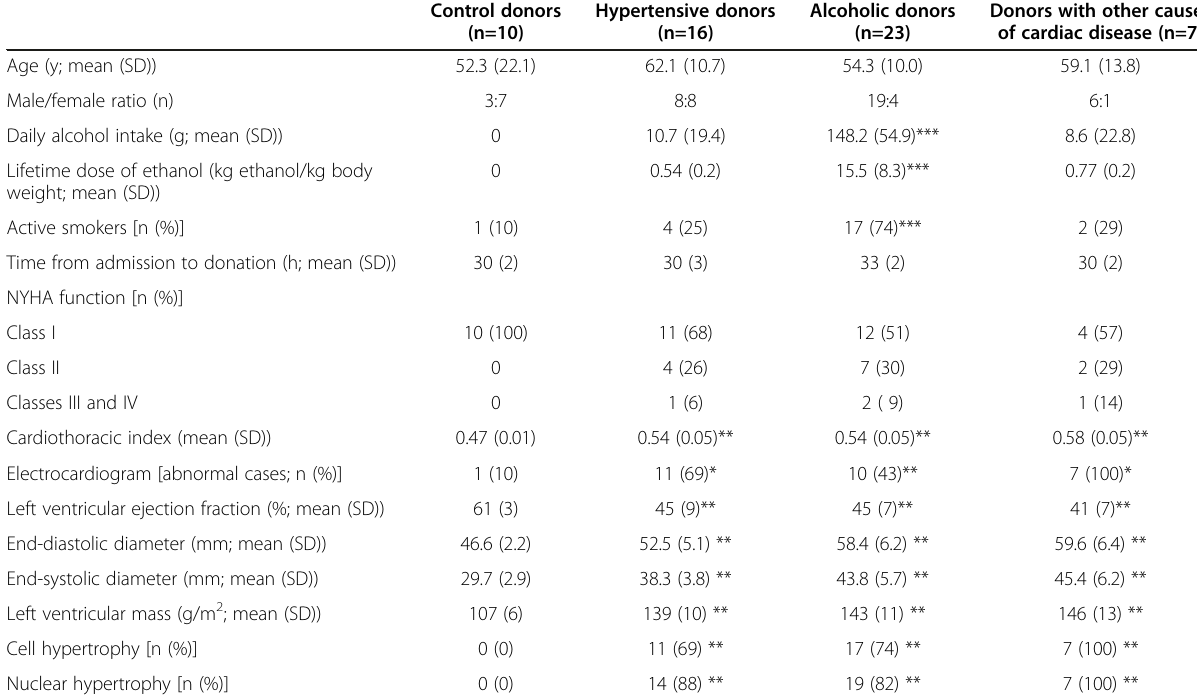
Table 1 Epidemiologic and clinical data of the different groups of heart donors